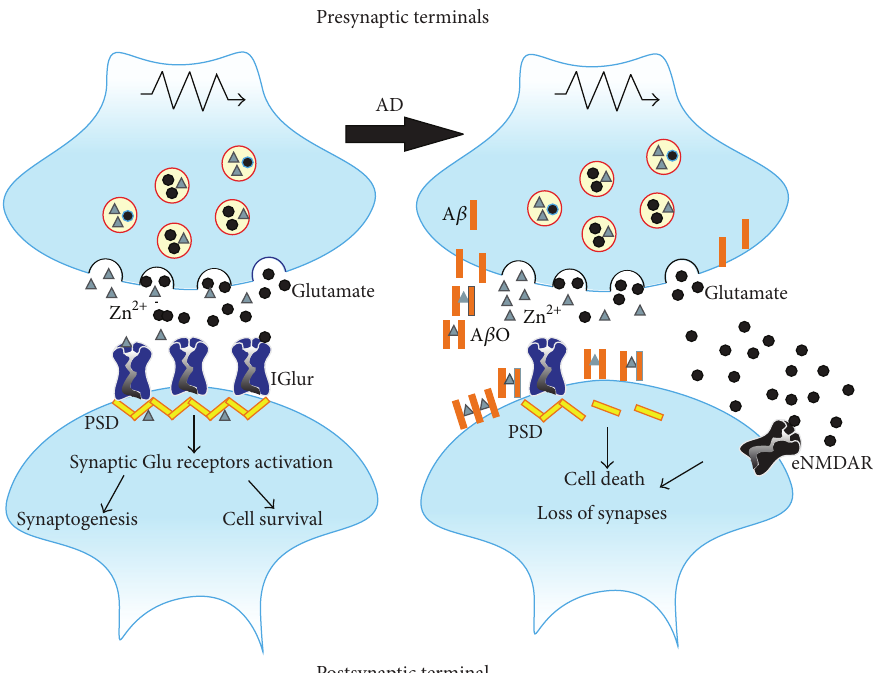
Figure 1: Intracellular signaling pathways activated by increased intracellular level Zn 2+ ; MT: metallothioneins; ATP: adenosine triphosphate; ROS: reactive oxygen species; NO: nitric